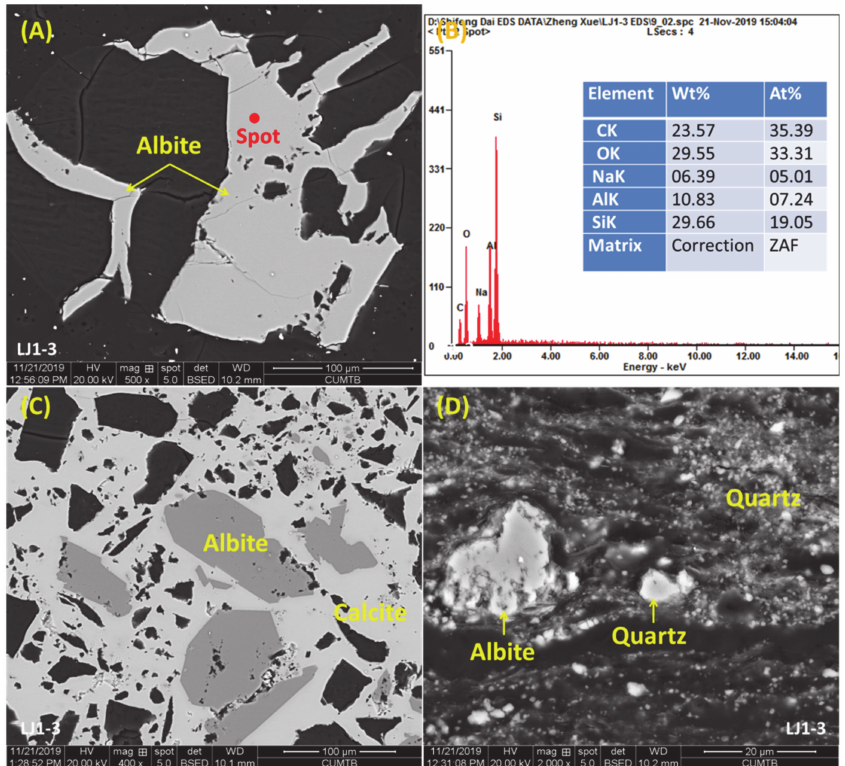
Figure 4. SEM backscattered electrons images of albite and other minerals in C1 coals and EDS data of a selected spot. ( A ) fracture-filling albite; ( B ) EDS spectrum of the red spot in ( A ); ( C ) calcite cement around albite and organic matter; ( D ) albite grain along the